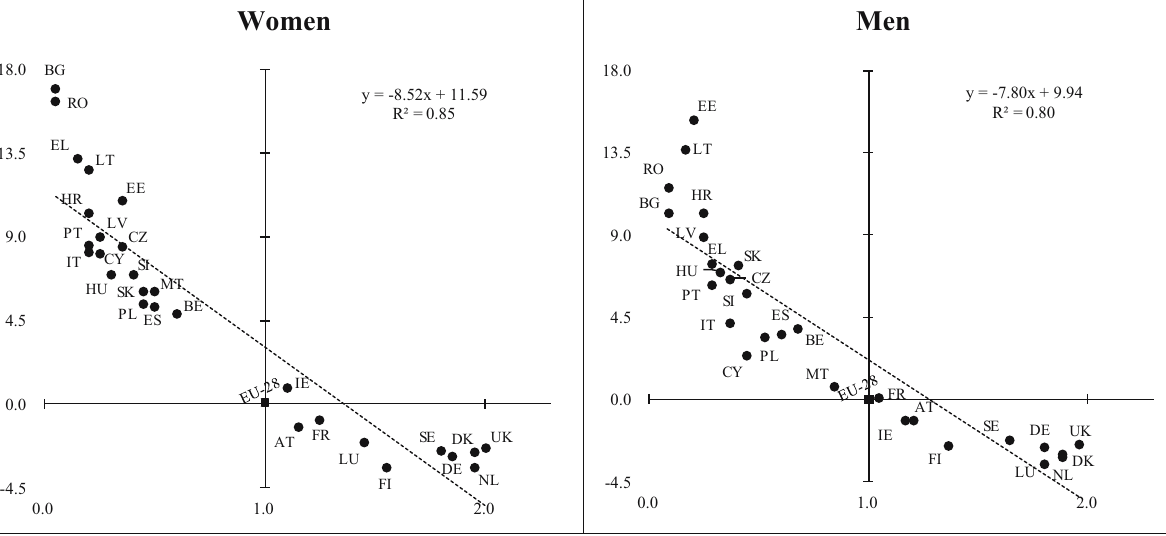
Figure 4: β - convergence in online shopping in the EU - 28, 2007 – 2019. Note: The abscissa represents the relative situation of women and men with respect to the EU - 28 ( which represents the unit ) in the 2007 ICT - PURCHASE indicator. The average annual growth di ff erential with the EU between 2007 and 2019 is represented on the ordinate. Source: Own elaboration from Digital Economy & Society Database ( Eurostat )